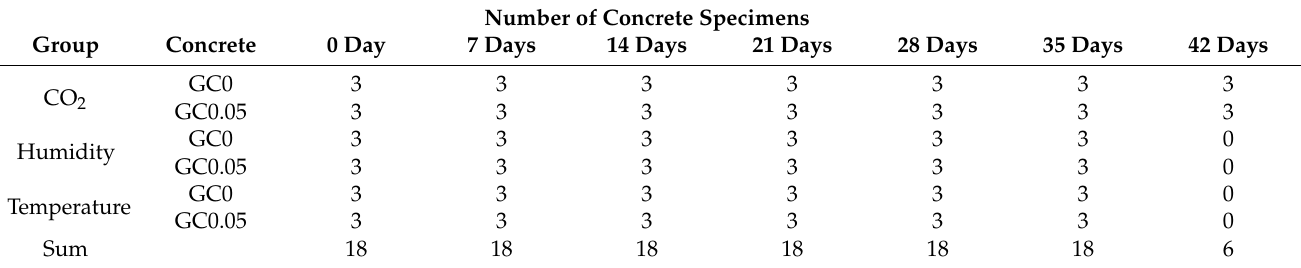
Table 3. Experimental